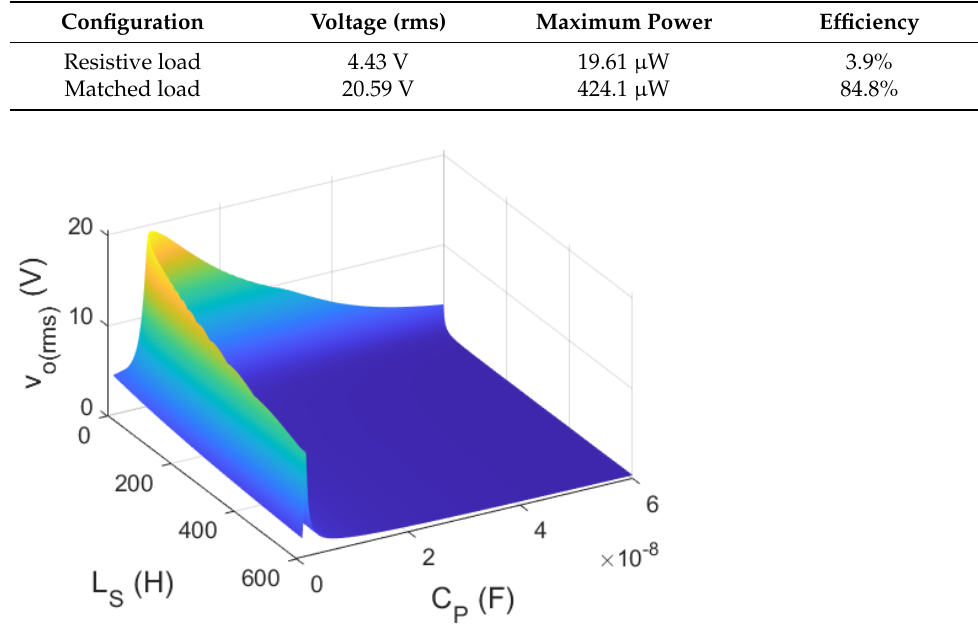
Table 2. Root mean square value of the output voltage, output average power and power efficiency for the energy harvester with the two different load setups.